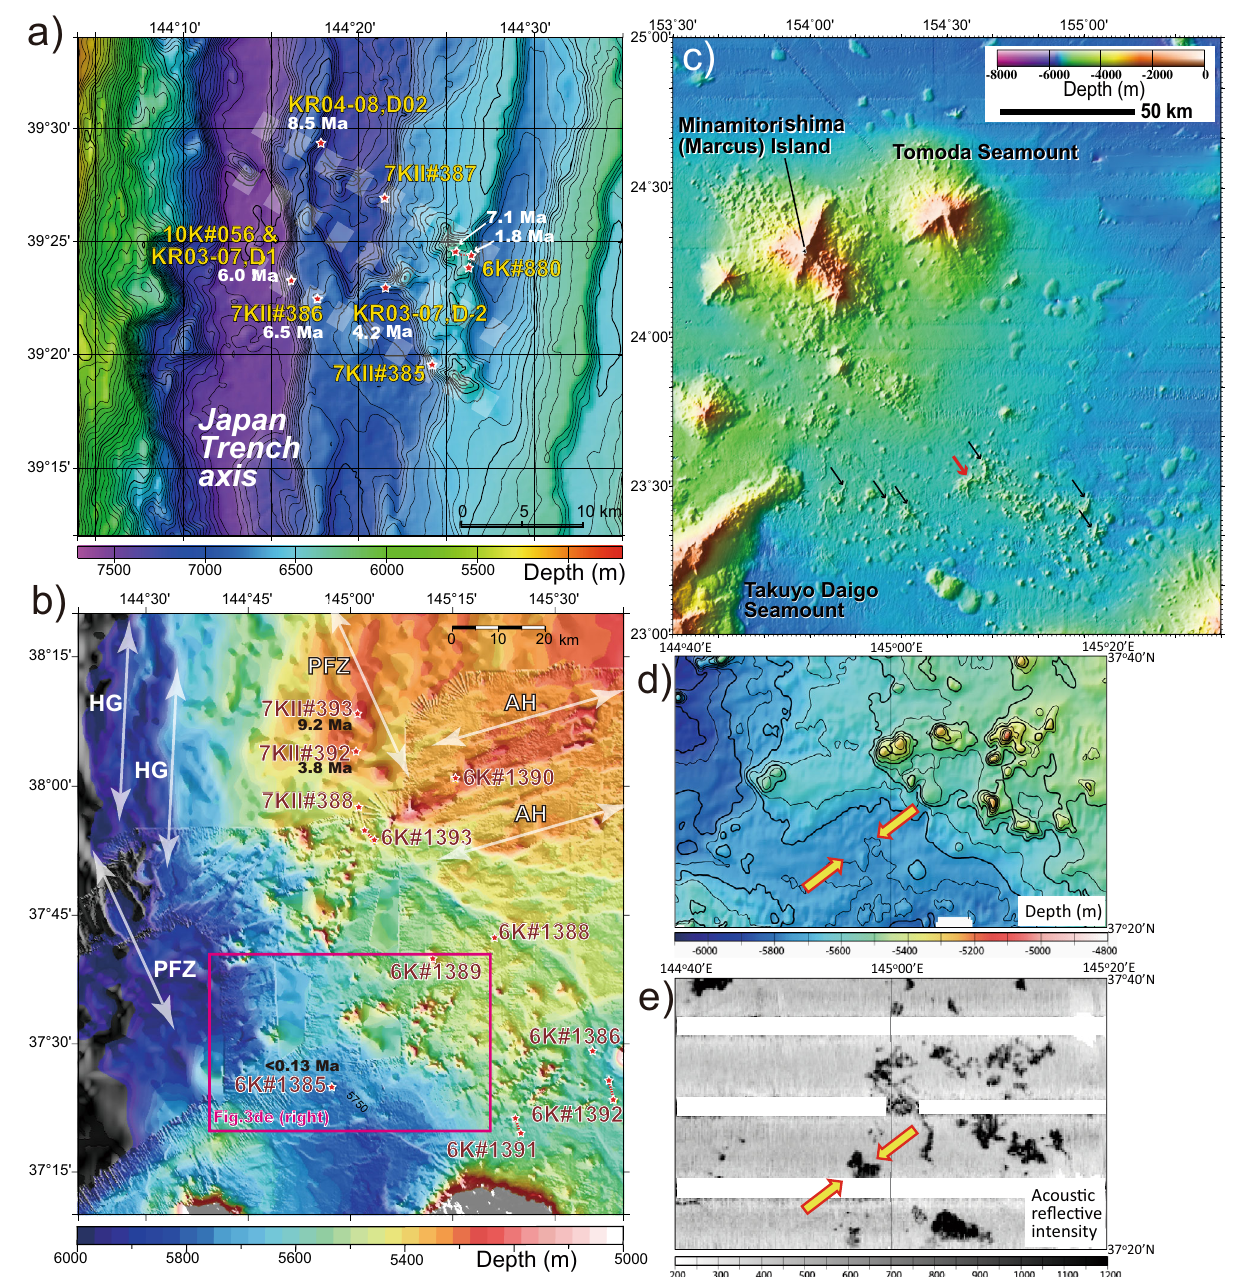
Fig. 3 Detailed bathymetric maps. a Sites A and b Site C in the NW Paci fi c Plate petit-spot volcanic fi eld 1 , and c SE offshore of Minamitorishima Island in the western Paci fi c Plate 14 (see Fig. 1 for locations). Sampling sites are indicated by small red stars and eruptive ages are provided in ( a , b ), when available 1,10,31,32,41 . Thick dashed lines in the panel a indicate lineations of monogenetic petit-spot volcanoes. In the panel b , white arrows designate lithospheric structures: AH, abyssal hills; PFZ, subparallel to fracture zone; and HG, horst and graben 27 – 29 . Young lavas, less than 3 Ma, are indicated by the red arrow in the panel c 14 . Black arrows in the panel c denote ridges aligned N – S to NNE – SSW in response to the fl exure or the outer rise of the western Paci fi c lithosphere (see also Fig. 2). Detailed bathymetric and acoustic re fl ective maps around the volcanic fi eld of DAP are shown in ( d , e ), respectively 10 (red square in the panel b ). The location of DAP is designated by thick yellow